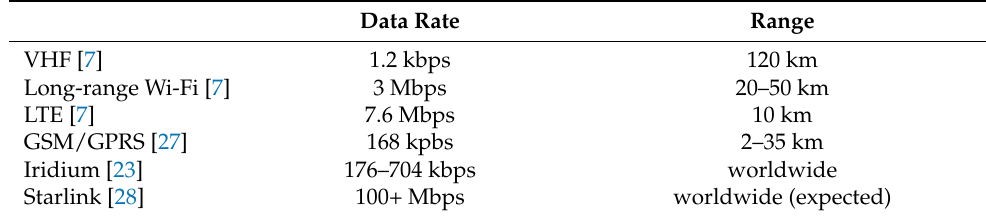
Table 2. Reported data rate and range performance of long-range communication protocols.